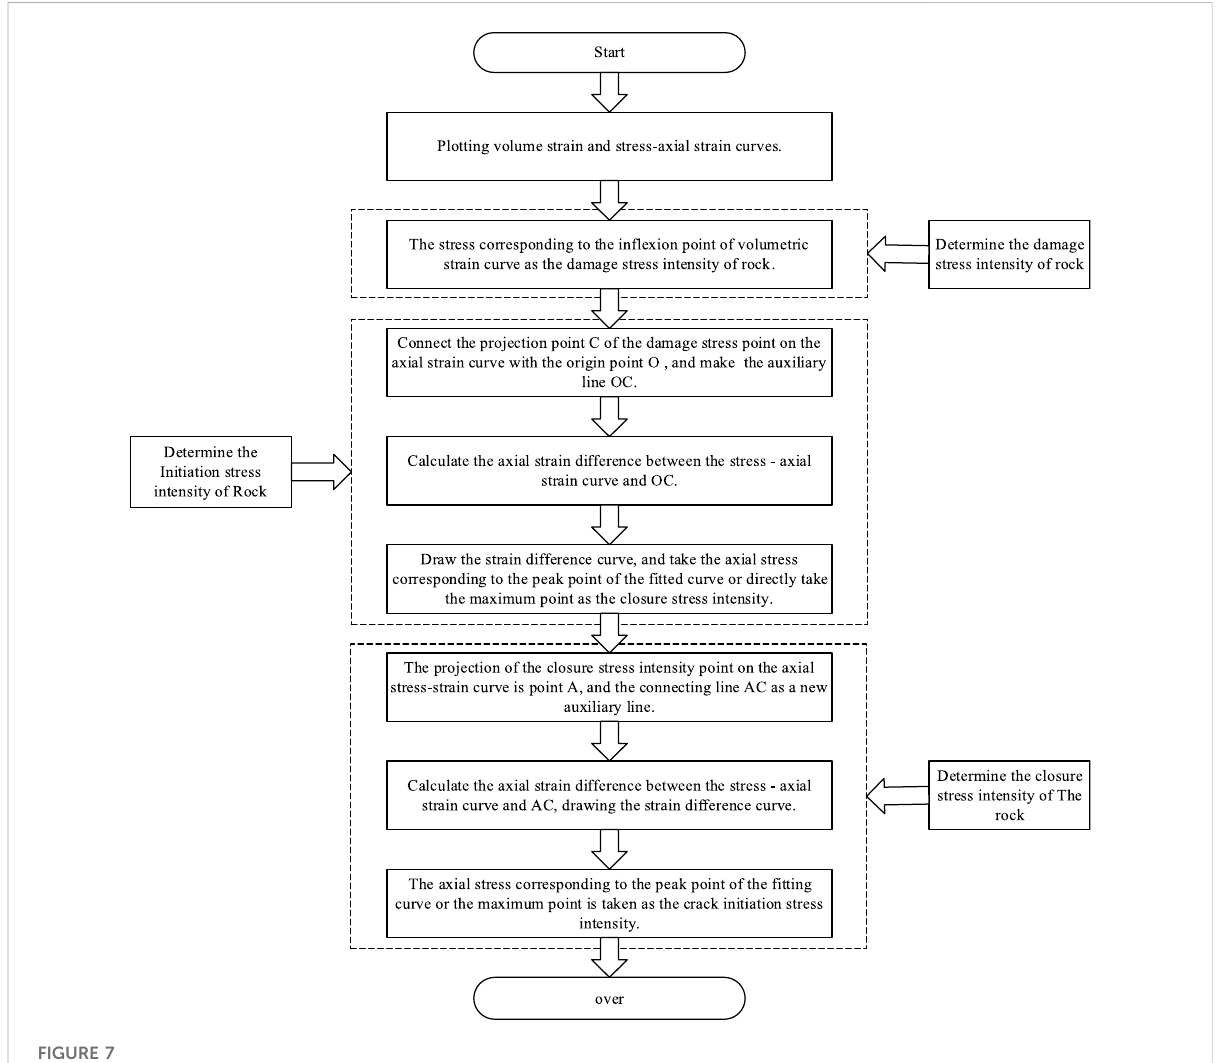
FIGURE 7 Flow chart of empirical value